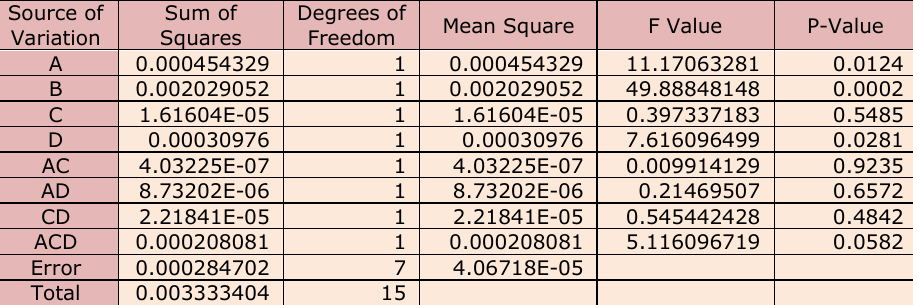
Table 6. Analysis of variance for the medication delivery